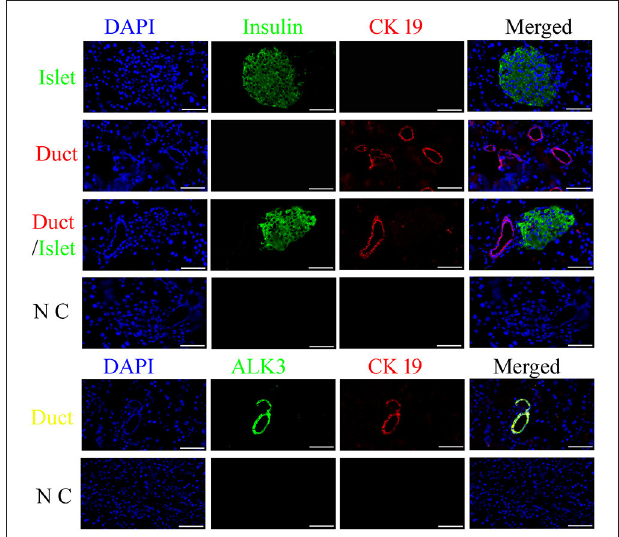
FIGURE 1 | Spatiotemporal distribution of canine pancreatic ductal cells. Insulin (green) is used to locate the pancreatic islets, and CK19 (red) and ALK3 (green) are the marker for duct, which were detected using an antibody with immunofluorescence analysis in the pancreas tissue, nuclear counterstaining with DAPI (blue). CK19 and ALK3 are the main markers for ductal epithelial cells, and CK19 and ALK3-positive cells were organized and formed a tubular structure, near insulin-positive cells. N C: negative control, the primary antibodies were replaced by FBS. Scale bar = 50 µ